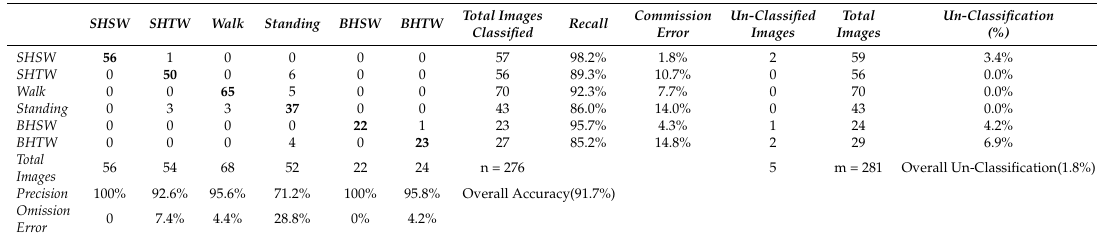
Table 5. Classification matrix for Eli images.